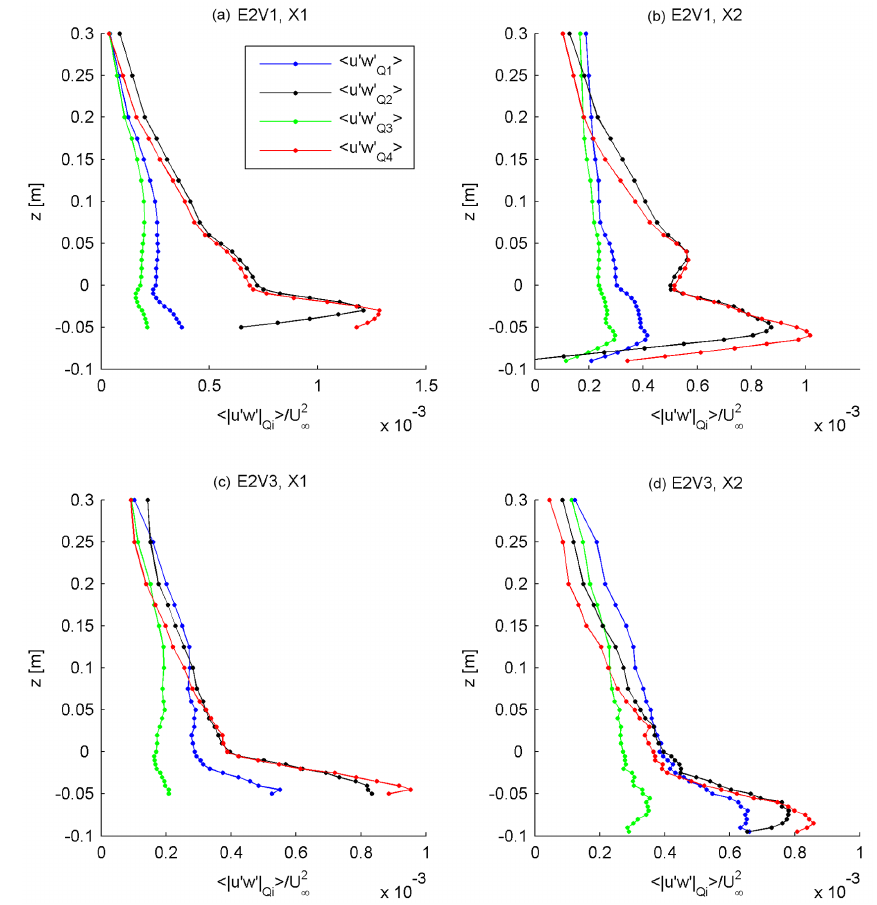
Figure 6. Shear stress contribution of the quadrants for the experimental setups E2V1 and